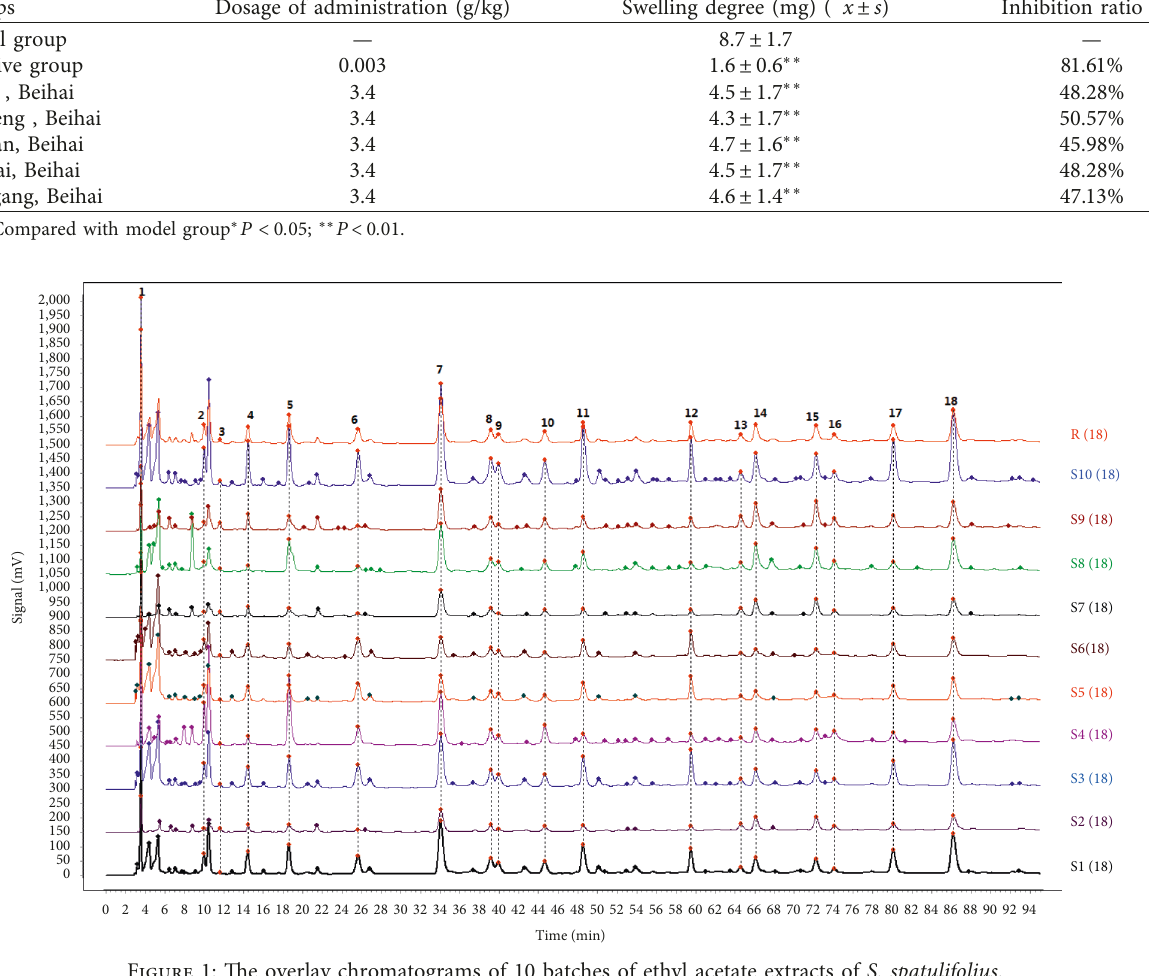
Figure 1: The overlay chromatograms of 10 batches of ethyl acetate extracts of S. spatulifolius